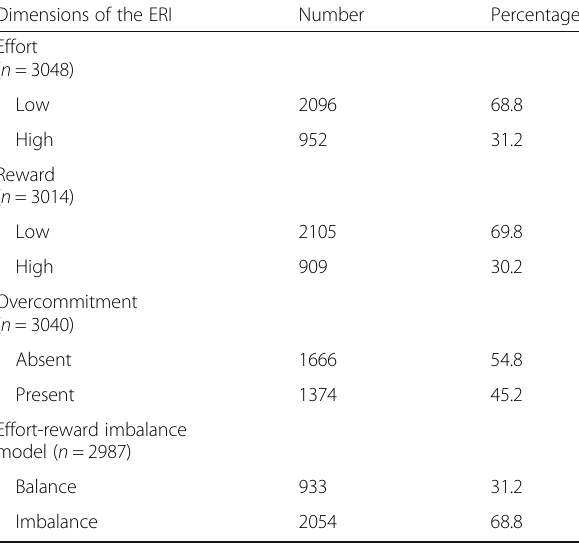
Table 2 Dimensions of the effort-reward imbalance model. Health workers, Bahia, Brazil, 2012